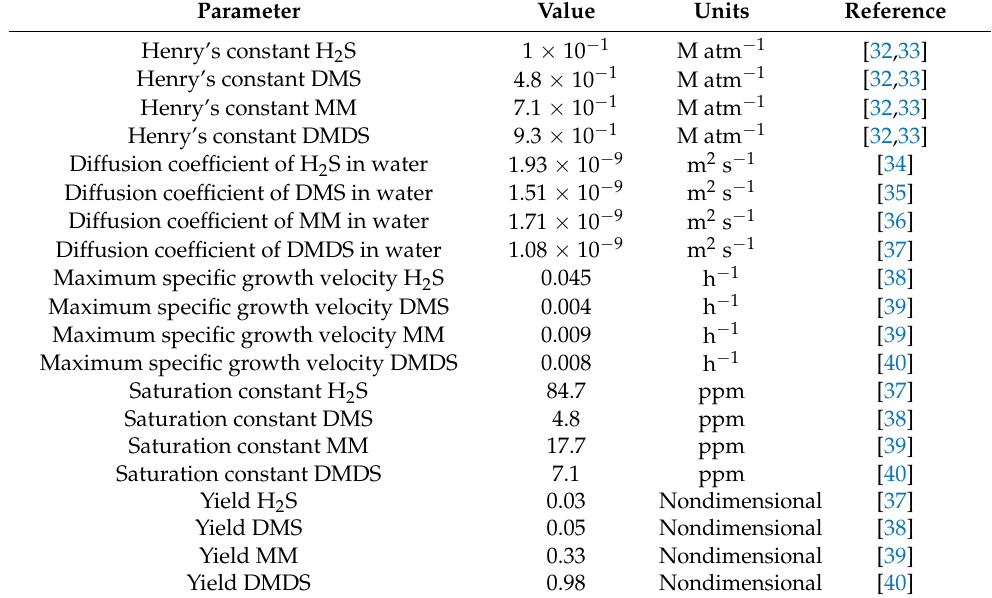
Table 1. Parameters used in